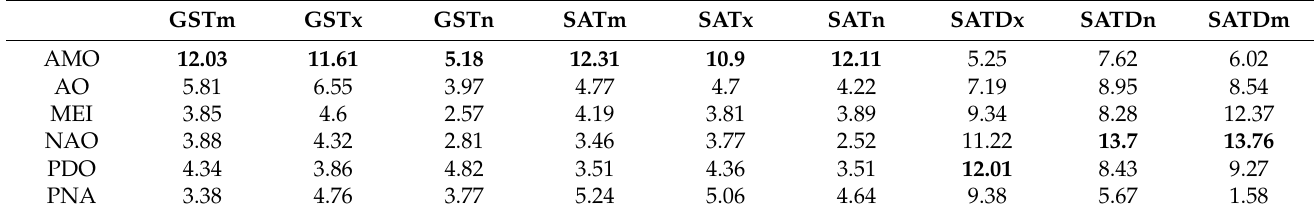
Table 8. Percentage area of significant ( p ≤ 0.05) coherence in bi-wavelet transform coherence between the anomaly of the monthly averaged GST-, SAT-, and SATD-related indexes and large-scale indexes in from 1980 to 2019 in Southwest China.